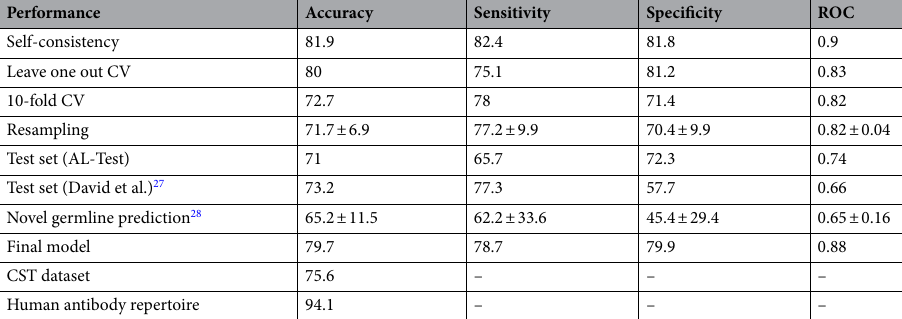
Table 1. Performance of the classification model for distinguishing between amyloidogenic and non- amyloidogenic variable domain light chain of antibodies. The standard deviation is mentioned for resampling and Novel germline prediction next to the performance measure. The final model was developed on complete AL-Base dataset (1828 sequences). The percent accuracy for CST dataset and human antibody repertoire represent the percentage of sequences predicted as